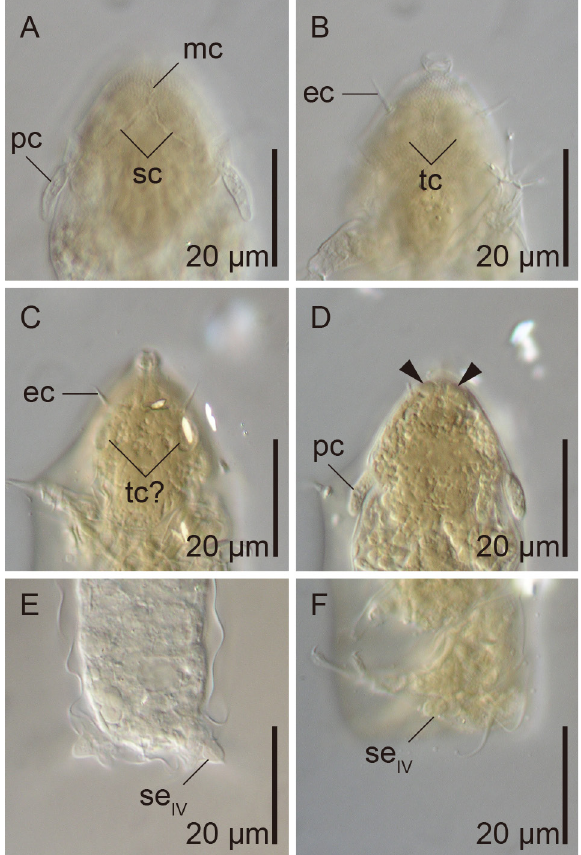
Fig. 3. Micrographs of specimens observed by Renaud-Mornant (1981) to describe Angursa abyssalis Renaud-Mornant, 1981 (A–B, E) and of Angursa sp. (C–D, F) by the present authors. A . Cephalic region (dorsal view) (MNHN AP345/560Ma). B . Cephalic region (ventral view) (MNHN AP345/560Ma). C . Cephalic region (ventral view) (MNHN AE120/78Ma). D . Cephalic region with paired globular bodies (black arrowhead) (MNHN AE120/78Ma). E . Leg IV sensory organs (MNHN AF05/77Ma). F . Leg IV sensory organ (MNHN